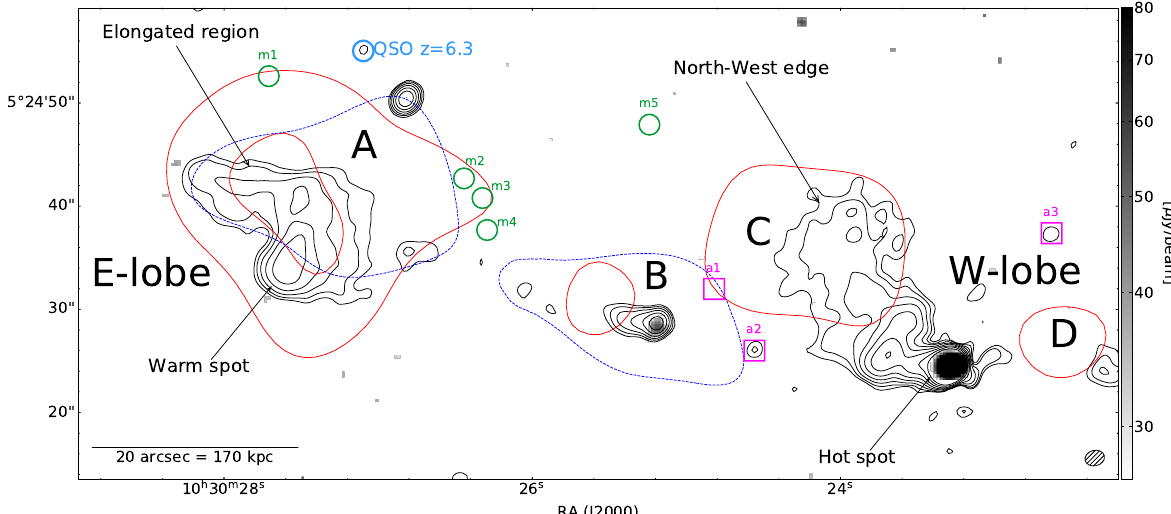
Figure 1. Image: ALMA continuum emission at 92.04 GHz, blanked at the 3 σ level. The black contours indicate the total intensity emission of the FRII HzRG at 1.4 GHz, starting at the ∼ 3 σ level emission and increasing with a progression. Blue (dashed) and red (solid) contours are the 2–3 σ soft and 2 σ hard X-ray diffuse emission, respectively. The four major components of such emission are labeled in black ( A – D ). The positions of the sources discovered by MUSE ( m 1 − m 5) are indicated by the green circles (a sixth source is located outside the image, ∼ 45 arcsec north-east from the FRII core). The positions of the protocluster members discovered by ALMA ( a 1 − a 3) are marked by the magenta boxes. The Eastern and Western lobes are labeled as E-lobe and W-lobe, respectively. The main morphological features of the lobes are also reported, indicated by the black arrows. The light blue circle indicates the z = 6.3 QSO (i.e., the center of the J1030 field). The solid black line at bottom-left corner shows the angular and physical scale, while the dashed ellipse at the bottom-right corner is the restoring beam of the ALMA